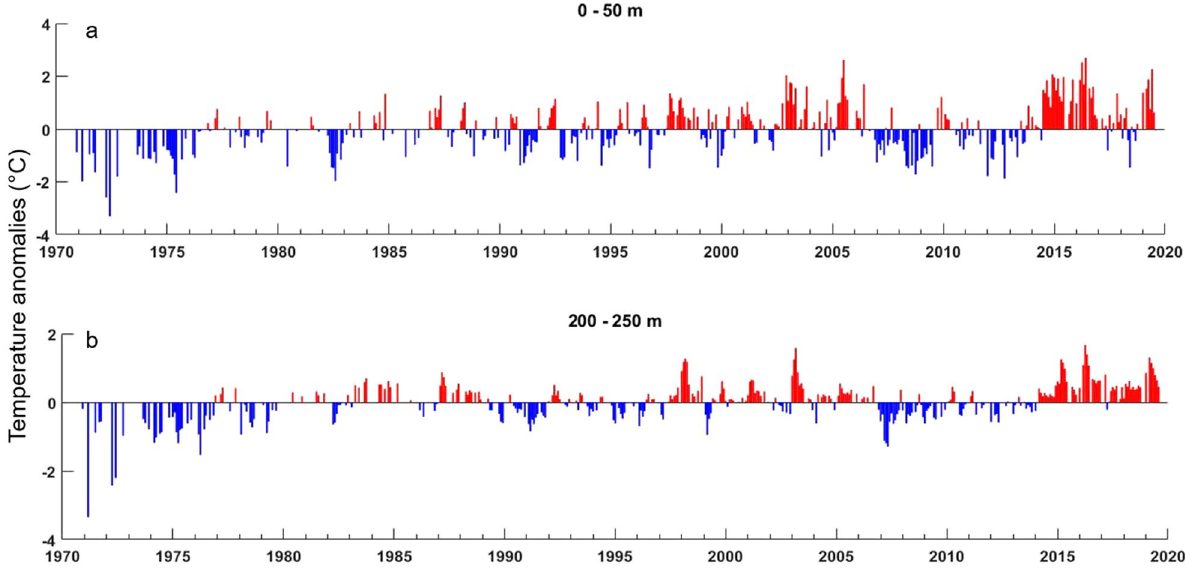
Figure 1. The multi-year heatwave that began in 2014 was the most persistent in the 48-year time series and it extended throughout the water column of the continental shelf. Temperature anomalies (°C) of the ( a ) upper (0–50 m) and ( b ) lower (200–250 m) water column at the GAK1 oceanographic station in the Gulf of Alaska, 1973–2019 (for location, see Fig.